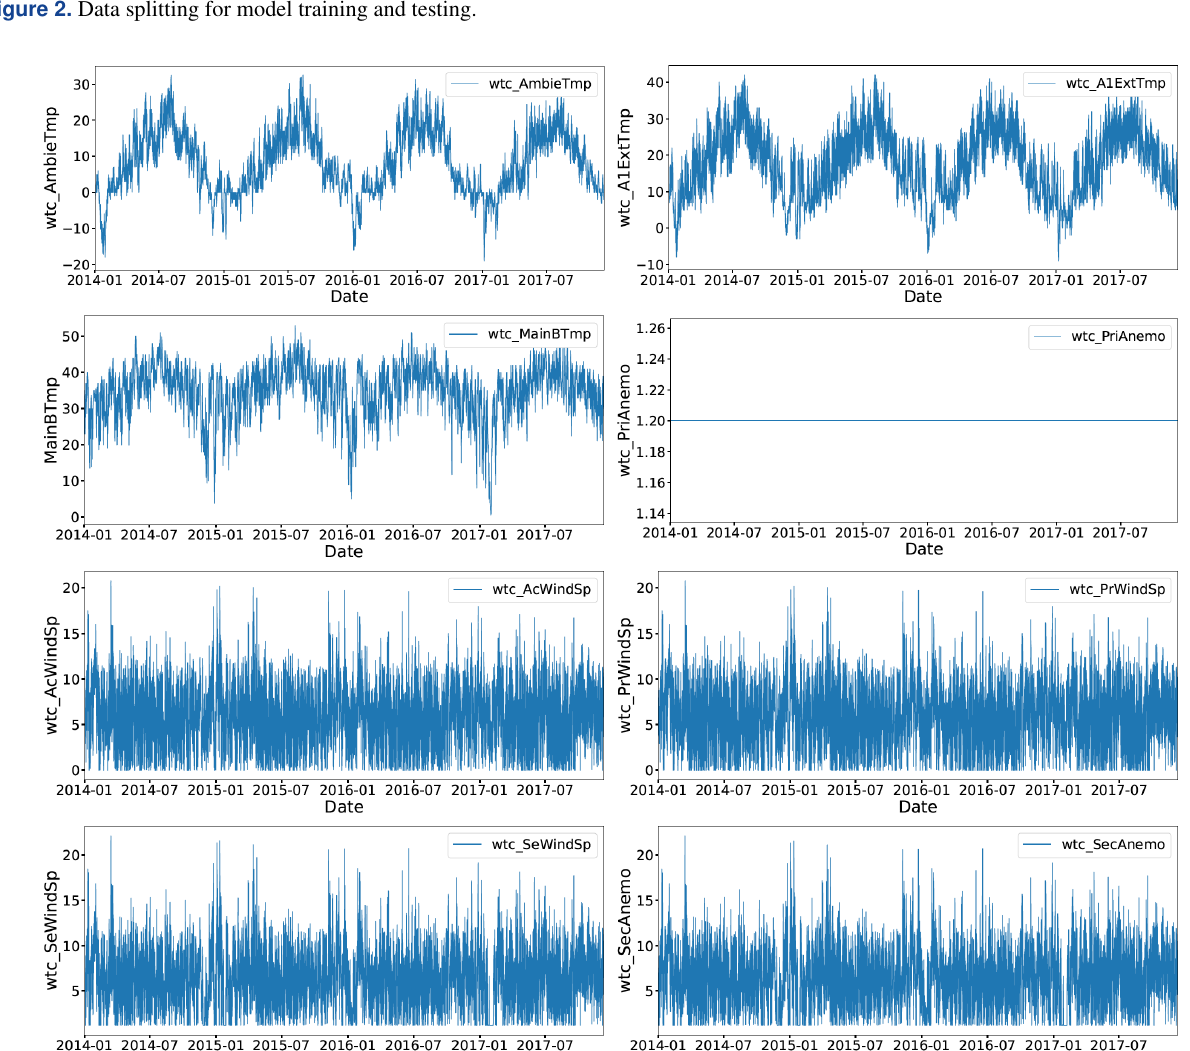
Figure 3. Exploratory data analysis for the selected